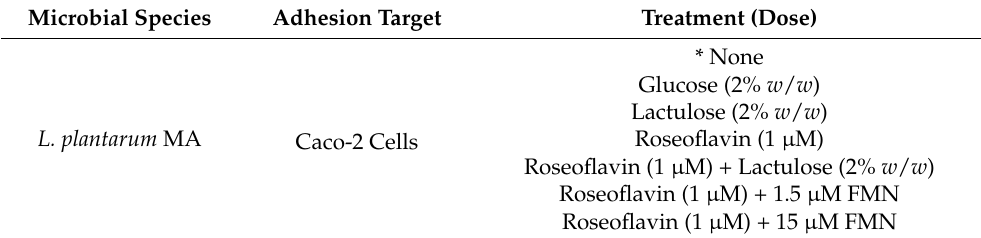
Table 2. Experimental design for microbial adhesion assay in vitro.